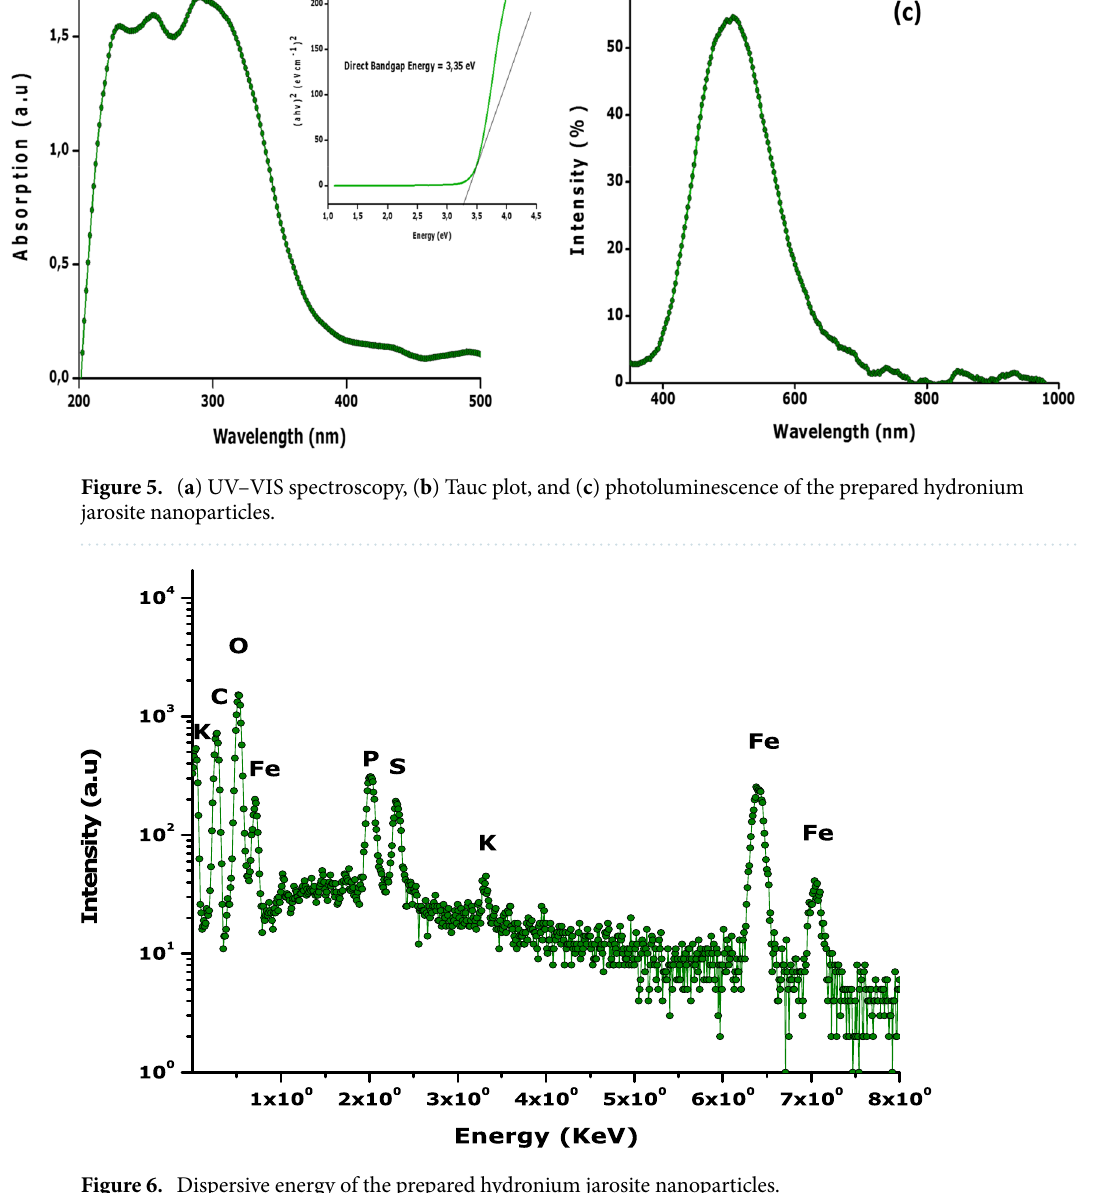
Figure 6. Dispersive energy of the prepared hydronium jarosite